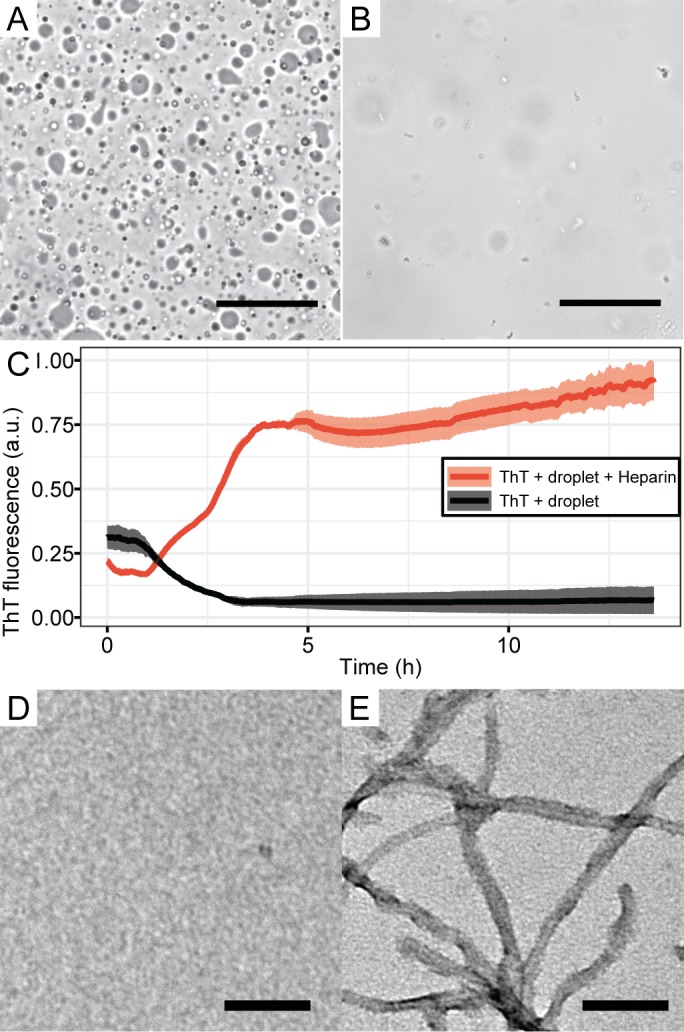
Tau-RNA CC upon addition of heparin.(A) 100 μM tau187C291S-SL and 300 μg/mL polyA RNA was mixed in the buffer of 20 mM ammonium acetate at pH 7, with 19 vol % glycerol. Images were taken after 10 min at room temperature. (B) Sample in A was re-prepared and incubated for 10 min. 25 μM heparin was added afterwards, immediately followed by imaging. The scale bars in both A and B are 50 μm long. (C) ThT fluorescences of samples in A and B were monitored with additional 10 μM ThT. (D) TEM images of sample in A after overnight incubation, showing no structures similar to amyloid fibrils. (E) TEM images of sample in B after overnight incubation, showing structures with length and width consistent with tau fibrils. The scale bars in both D and E are 200 nm long.